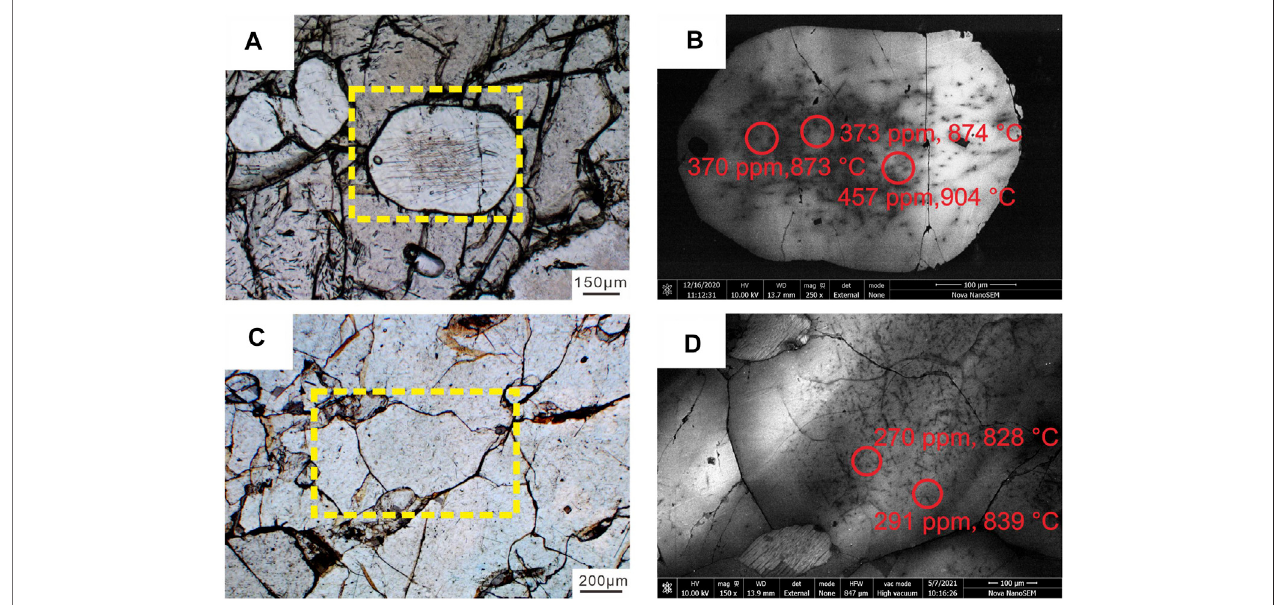
FIGURE 7 | Representative photomicrographs and CL images of the analyzed quartz grains showing linear structure with low luminescence. (A) Quartz inclusion within garnet in sample 09JGQ15 and CL image is shown in (B) ; (C) Matrix-type quartz in sample 09DSZ17 and CL image is shown in (D) .